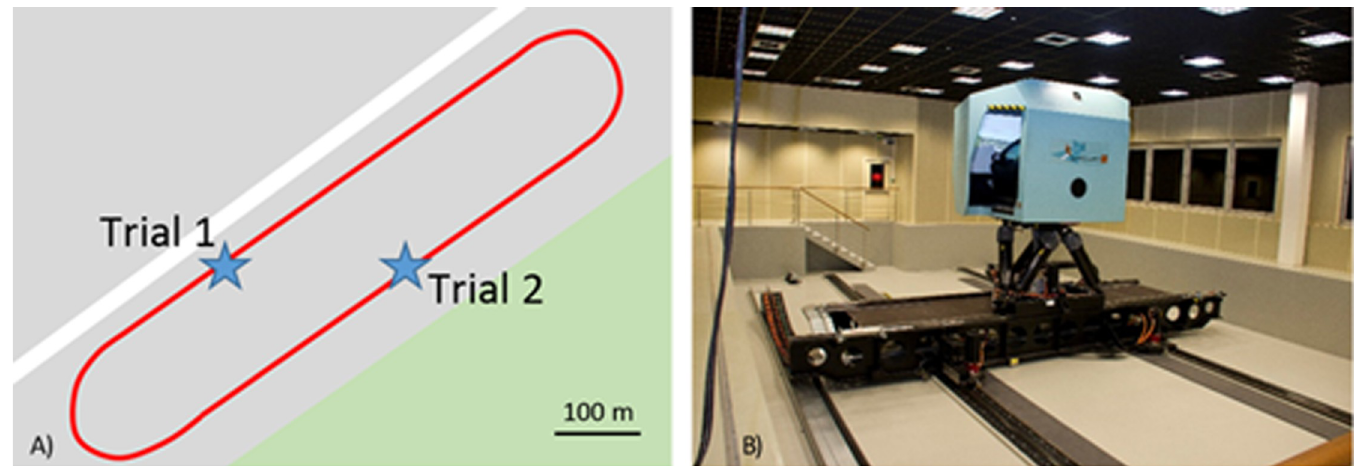
Fig 1. A. The Sherpa2 driving simulator. B. The map of the circuit. In red, the loop circuit used by the drivers. Blue stars give the positions of the gym balls crossing the driver’s path at kilometer 6 (trial 1) and kilometer 12 (trial 2).